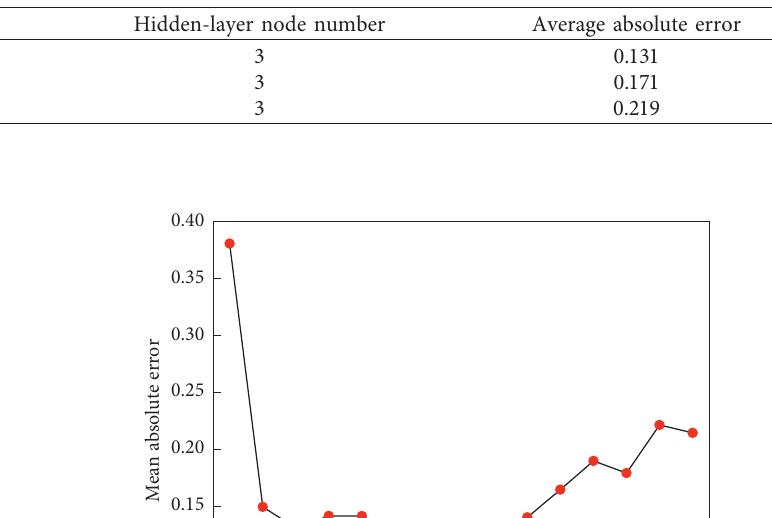
Table 3: Selection of activation function.